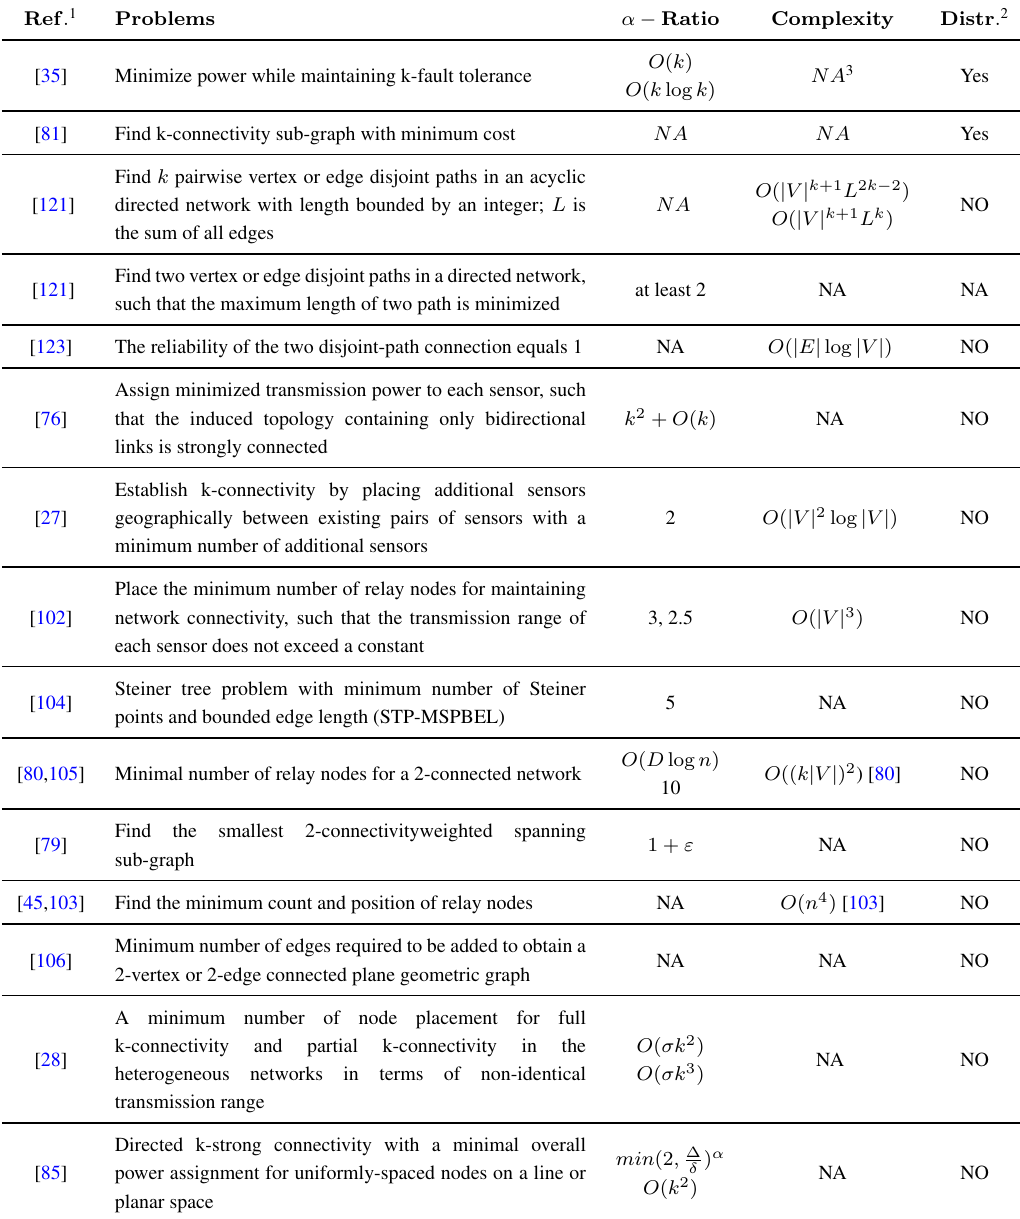
Table 1. NP-complete and NP-hard problems in resilient